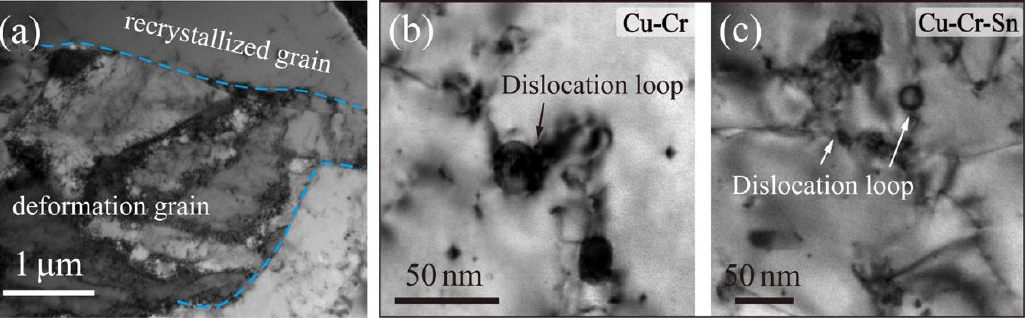
Figure 6. Bright-field images of ( a , c ) Cu-Cr-Sn and ( b ) Cu-Cr alloy after 700 °C annealing for 60